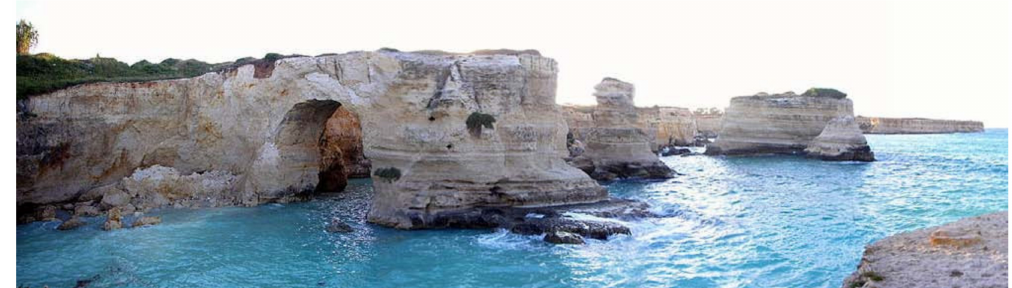
Figure 3. Overview of the Sant’Andrea coastline.